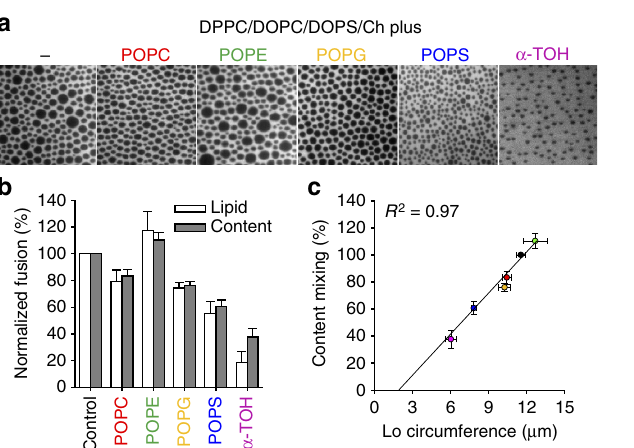
Figure 6 | Effect of linactants on Lo domain formation and membrane fusion. ( a ) Fluorescence micrographs of supported lipid monolayers composed of DPPC/DOPC/DOPS/Ch (2:1:1:1) (control) with 20mol% linactants (hybrid phospholipids and a -TOH) as indicated. The statistics of several observed parameters on the Lo domains as calculated by ImageJ are shown in Supplementary Fig. 3a. The scale of all images is 40 (cid:2) 40 m m 2 . ( b ) Effect of linactants on membrane fusion mediated by HIV-FP. The extent of lipid (white bars) and content (grey bars) mixing was measured 10min after addition of 1 m M HIV-FP to 50 m M LUVs composed of the same lipid mixtures as in a . ( c ) The dependence of content mixing on the circumference of Lo domains shows a linear relationship (correlation coefficient R 2 ¼ 0.97). The coloured data points correspond to the colours of the added linactants in a , b . The direct correlation of content (or lipid) mixing with the circumference of the domains indicates a critical role of the Lo/Ld interface line tension in membrane fusion. Data are mean ± s.e.m. from three experiments.